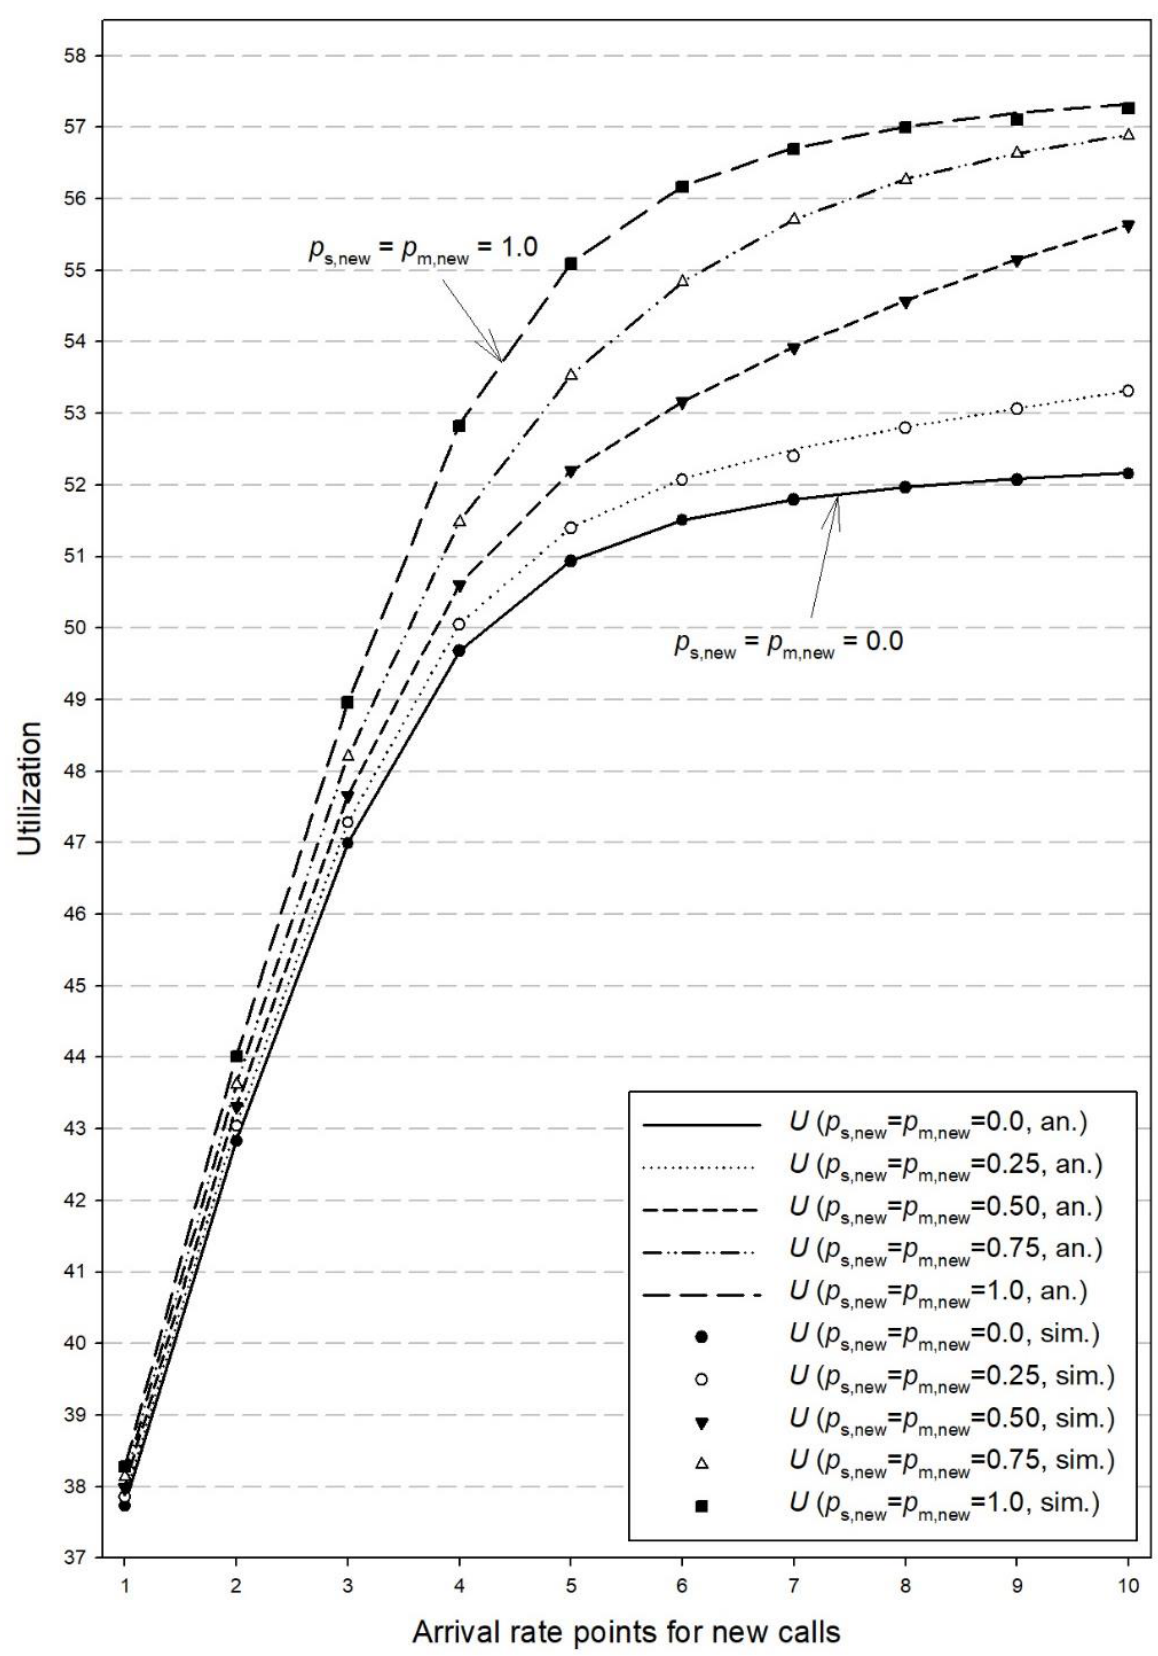
Figure 5. Utilization for different values of λ new .